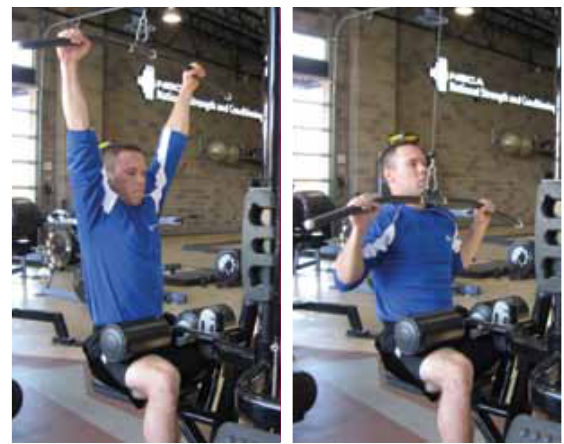
Figure 4-34. Start Position Figure 4-35. Finish